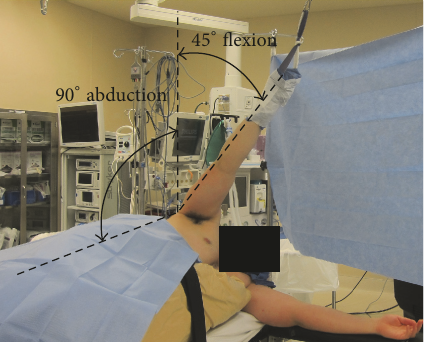
Figure 4: Recreation demonstrating 45 ∘ of flexion and 90 ∘ of